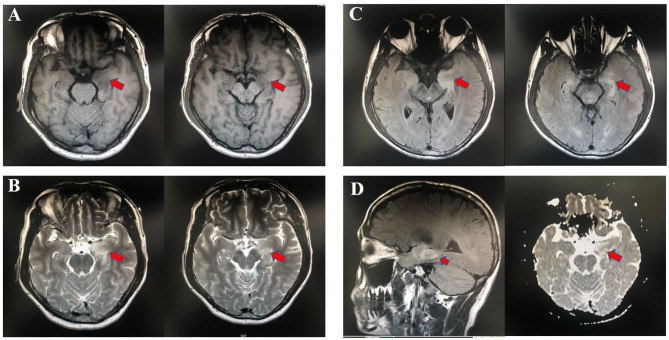
Abnormal MRI signaling (Red arrows) in the left hippocampus and parahippocampal gyrus of one patient with anti-LGI1 encephalitis. (A) TI-weighted MRI. (B) T2-weighted MRI. (C) Aixal FLAIR sequences. (D) Sagittal FLAIR MRI and axial DWI. MRI, magnetic resonance imaging; FLAIR, fluid attenuated inversion recovery; DWI, diffusion-weighted imaging.